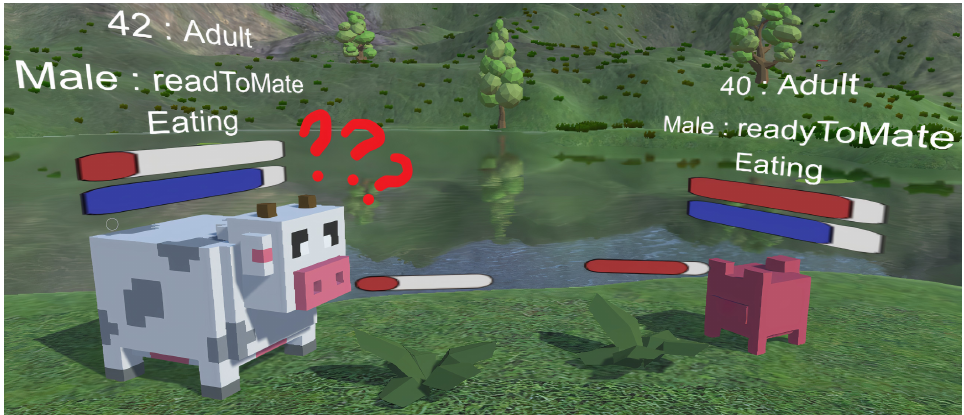
Figure 12. With a better metabolism animals burn energy slower and consume less food from the environment.